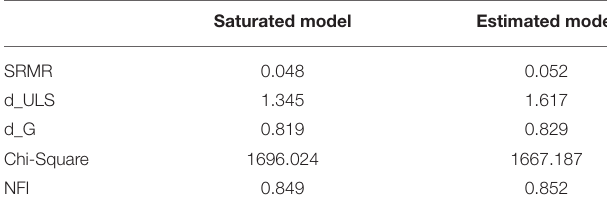
TABLE 7 | Model fit evaluation.